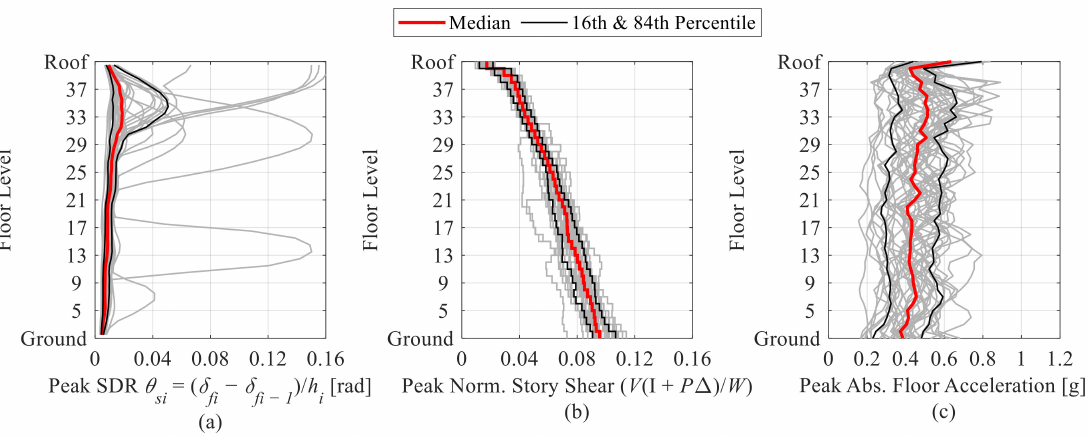
Figure 4. Engineering demand parameters in the X-loading direction (BSE-1E), ( a ) peak SDR, ( b ) peak normalized story shear force, ( c ) peak absolute floor